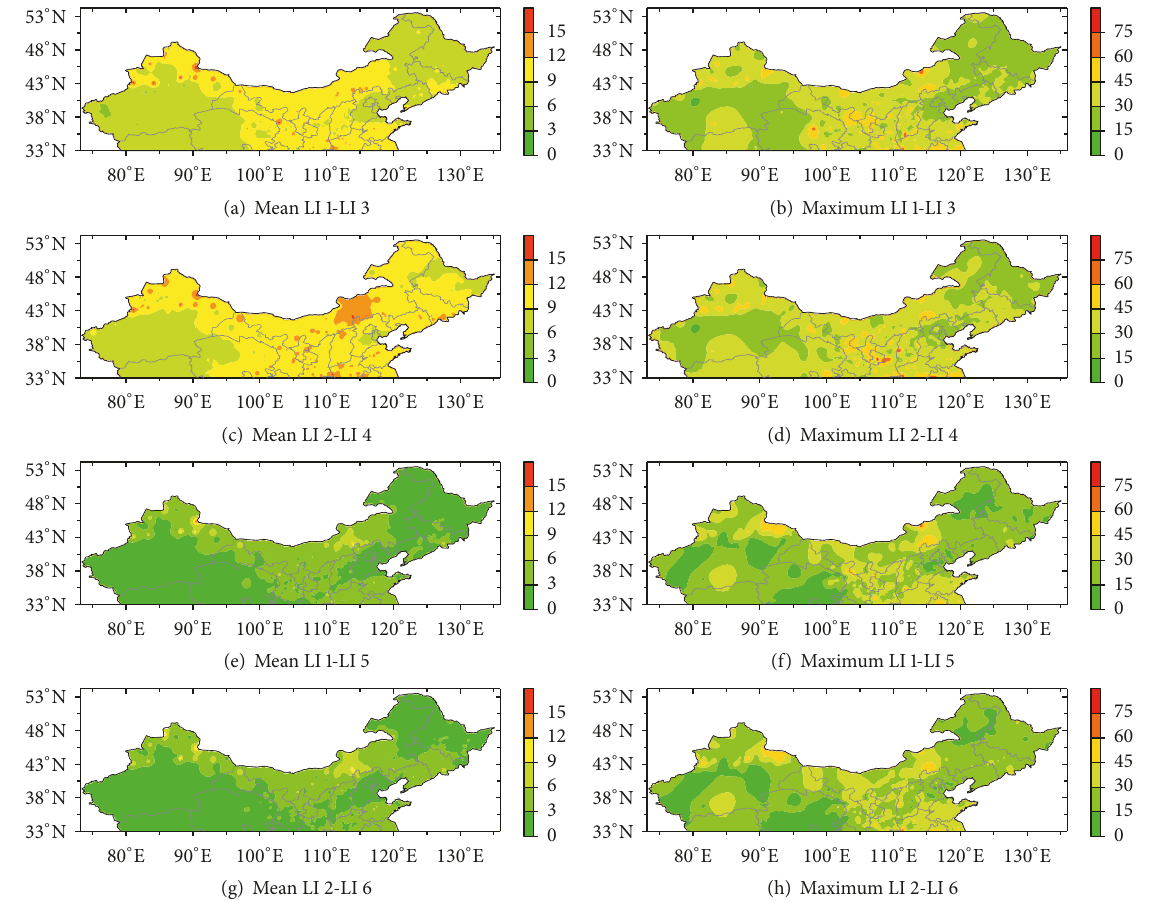
Figure 7: Differences (days) in the length of the growing season between selected indices in northern China. Shown are the mean values ((a), (c), (e), and (g)) and maximum values ((b), (d), (f), and